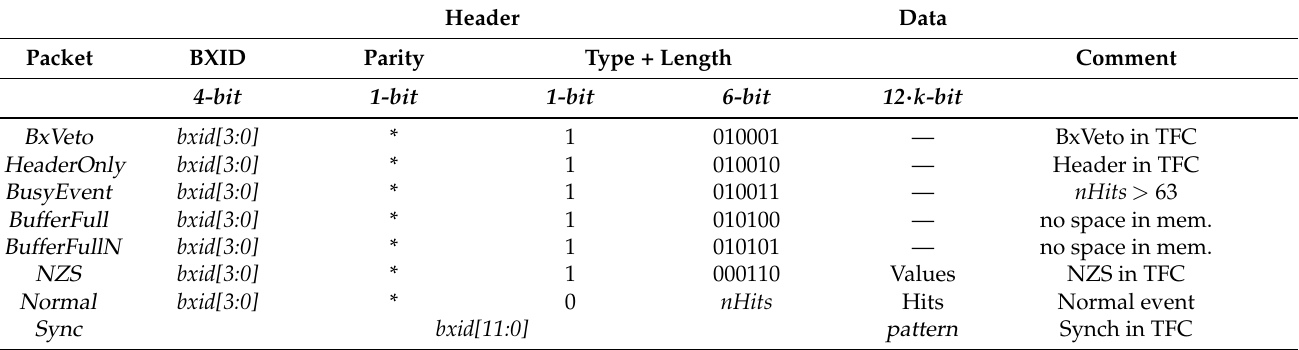
Table 2. Data packet format. Both parts Header and Data are aligned to 12-bit word; parity bit ’*’ is calculated as the exclusive or of all other bits in the header; k = 0, 1, 2, ..., 66.